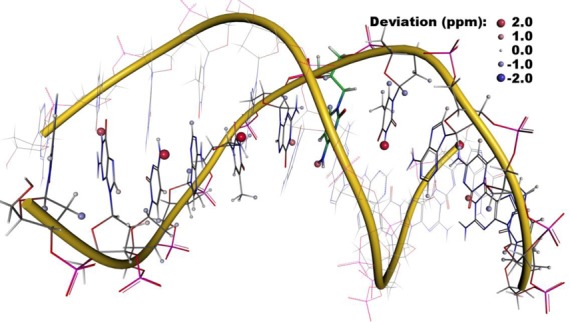
Spatial distribution of errors in the calculated 1H NMR chemical shifts for the first chain of a DNA duplex containing the potent anti-poxvirus agent cidoflovir (PDB entry 2L8P): Cidoflovir is marked in the middle with green carbon atoms. The nuclei of the two groups, which are predicted high-field-shifted compared to the experiment, are clearly seen as the large red spheres with errors larger than 1–2 ppm.